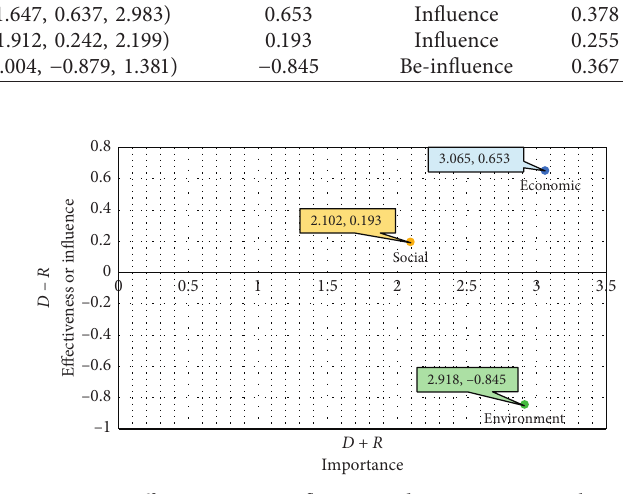
Figure 7: Effectiveness or influence and importance weight of sustainability dimensions.